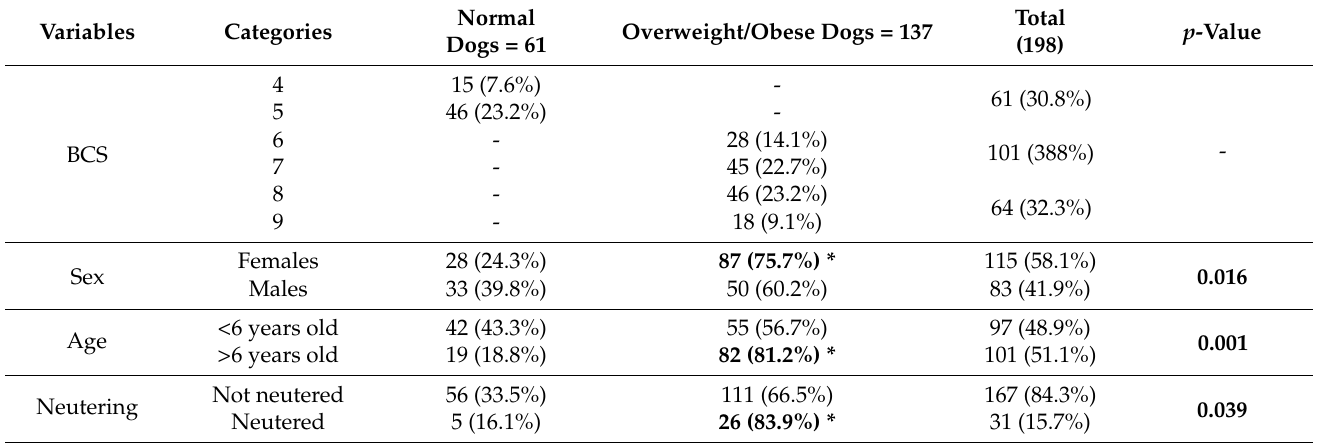
Table 1. Distribution of the dogs according to BCS, sex, age, and reproductive